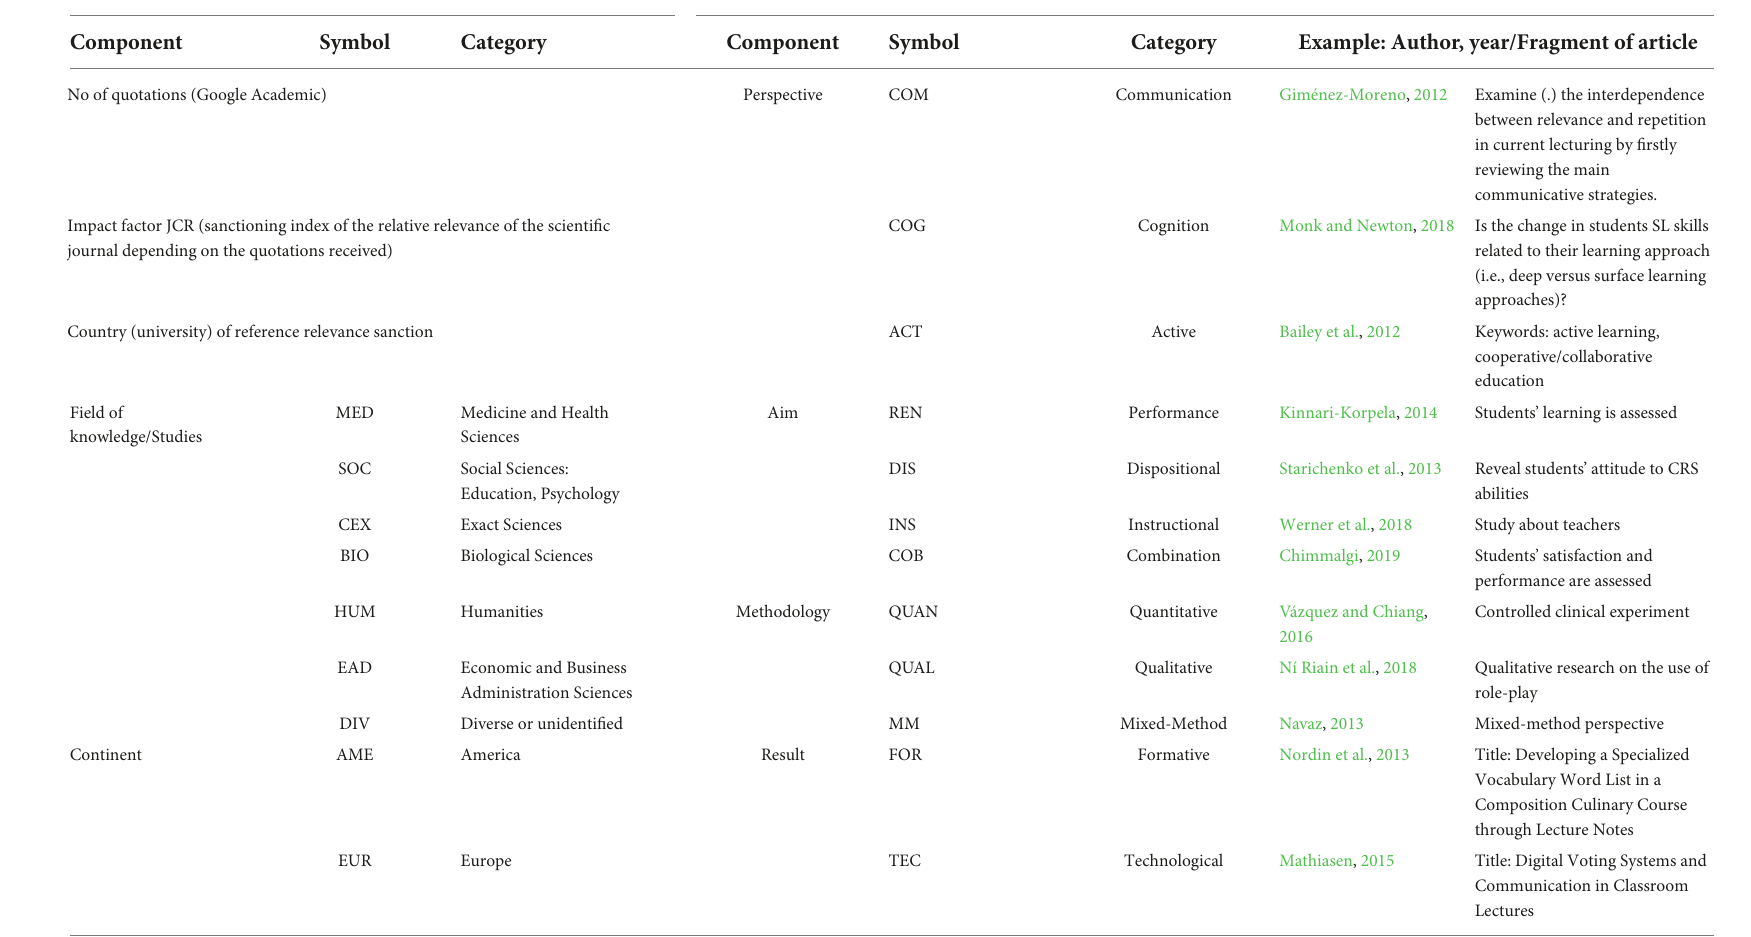
TABLE 2 Dimensions of the analytical framework with components, symbols, categories, and examples for the analysis of the obtained data. Dimensions of the analytical